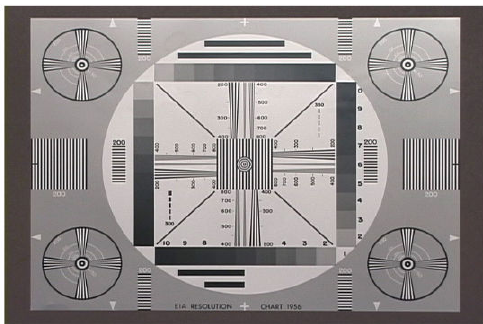
Figure 1. EIA 1956 Test Pattern (Messina, 2006)